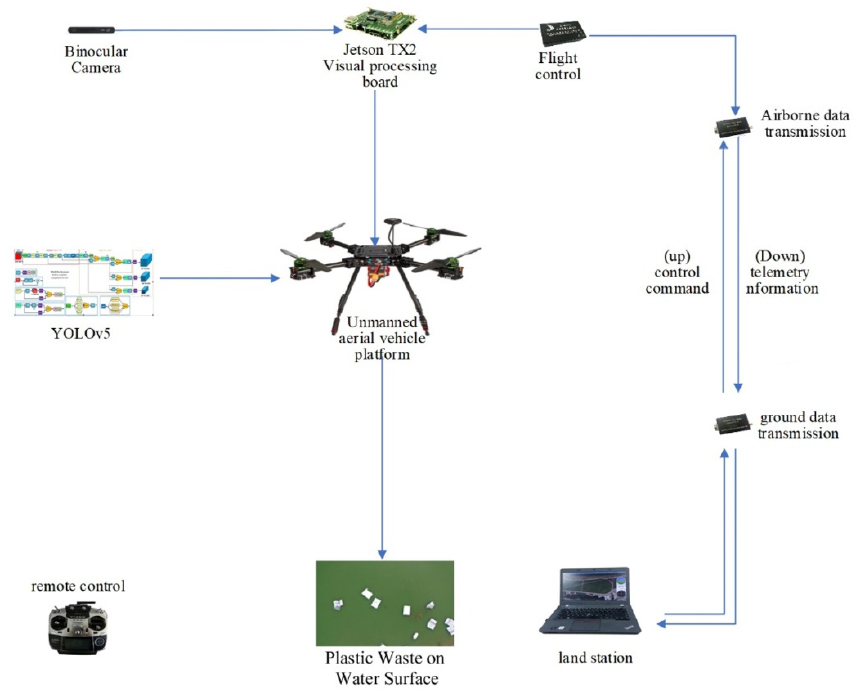
Figure 4. Research framework of this study.